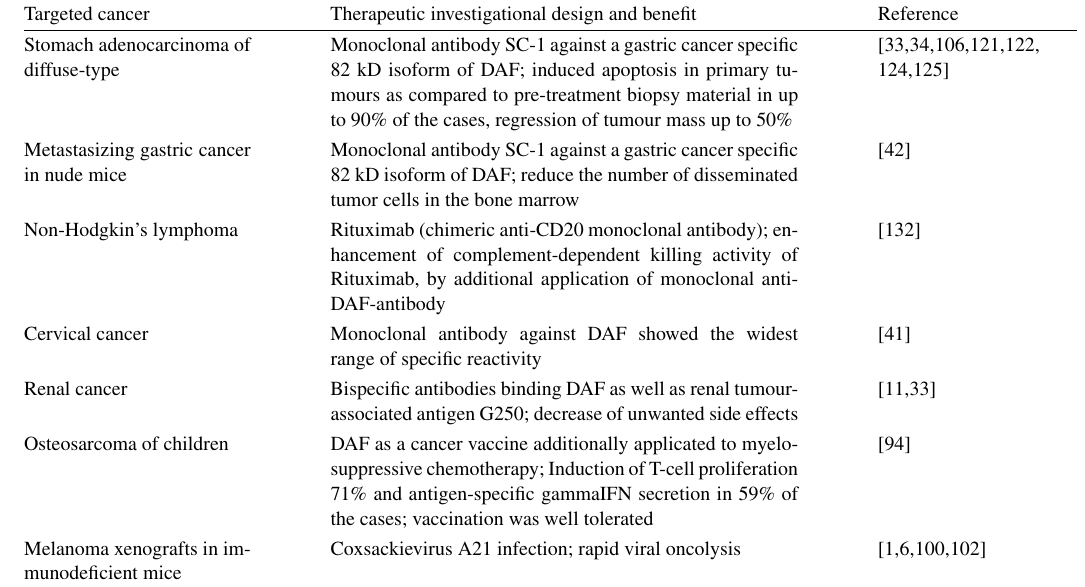
Perspectives of DAF targeted